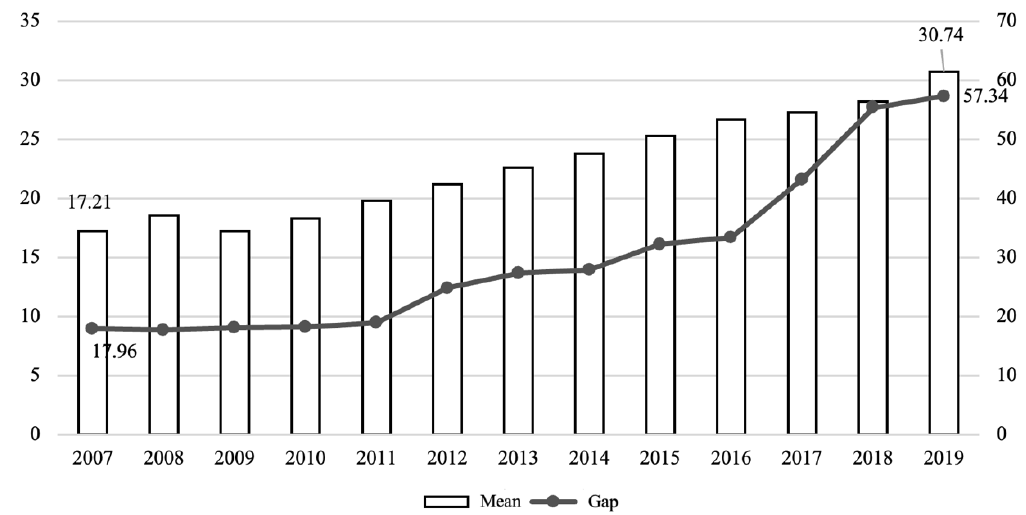
Figure 1. Mean and gap of commercial health insurance development index in various regions from 2007 to 2019.